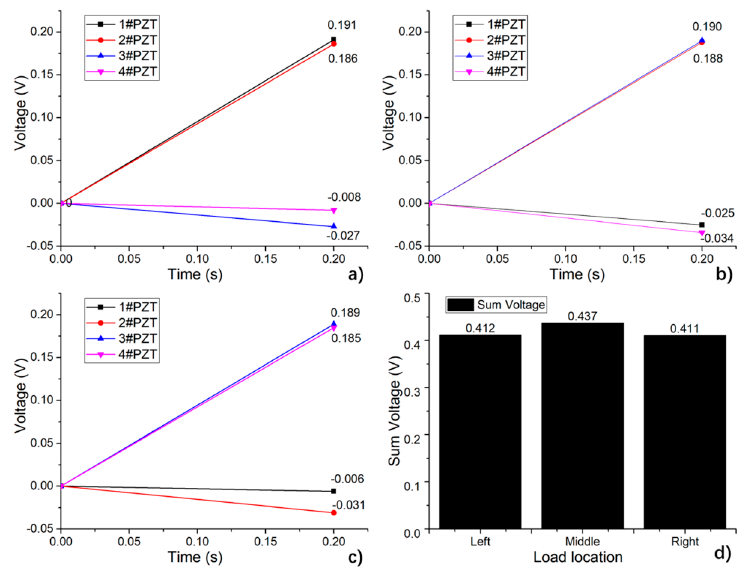
Figure 23. Output of the system changing with loading position. ( a ) Load on the zone in the middle of 1# and 2# (Left); ( b ) load on the zone in the middle of 2# and 3# (Middle); ( c ) load on the zone in the middle of 3# and 4# (Right); ( d ) comparison of the total output at different load locations.